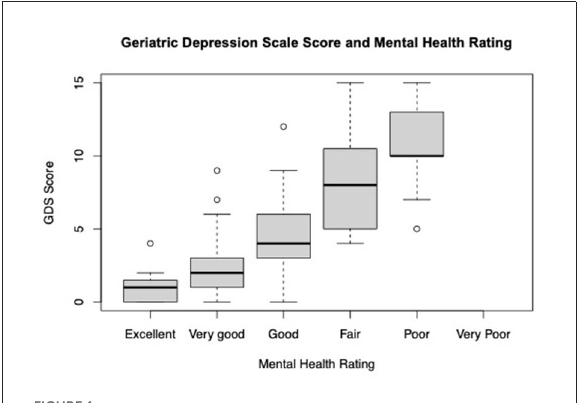
FIGURE1 Average GDS score by self-reported mental health rating ( n =